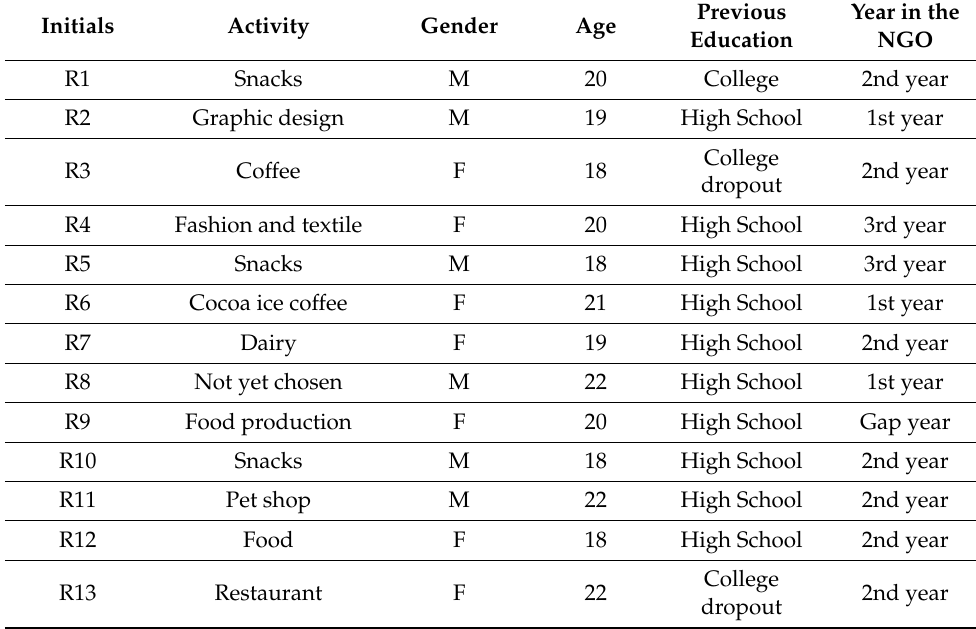
Table 1. Characteristics of interviewed